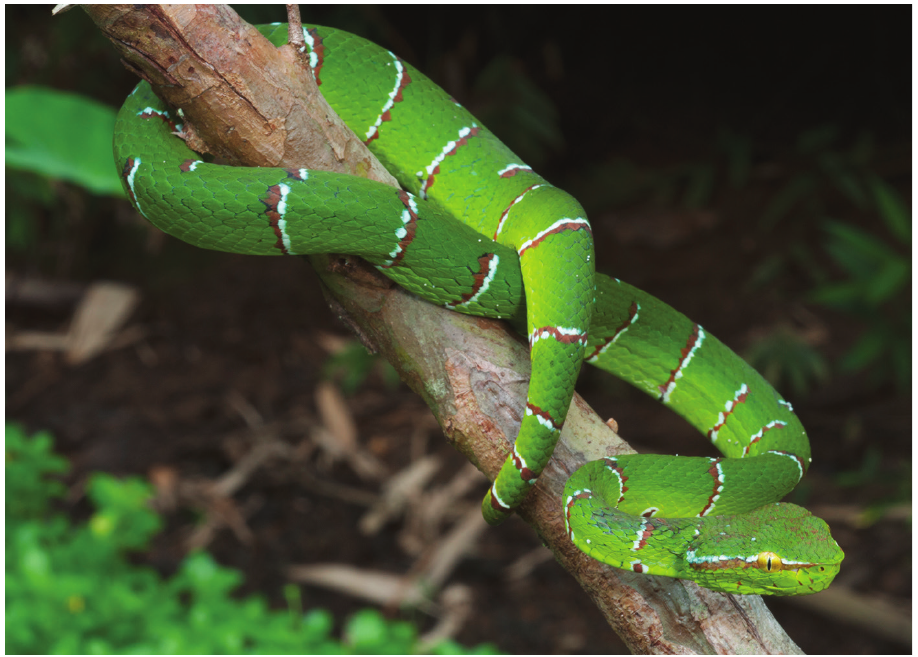
Figure 79. Tropidolaemus subannulatus (KU 306592) from Barangay Esperanza, Municipality of Loreto, Dinagat Island. Photo: